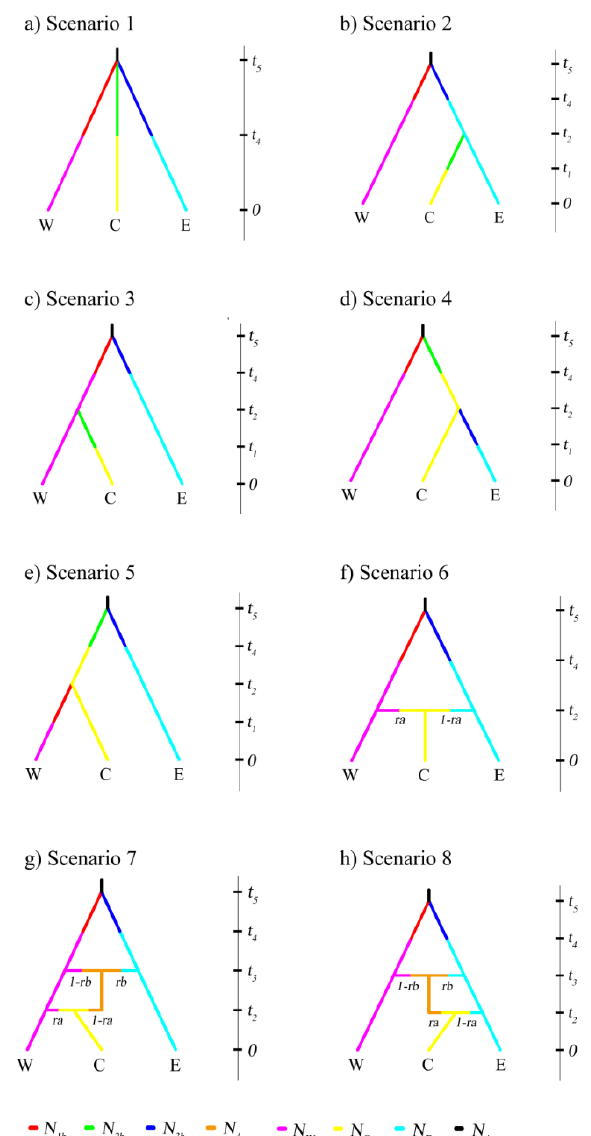
Figure A1. Eight hypothesized evolutionary scenarios for the western, central, and eastern groups of Castanopsis sclerophylla . N A , N W , N C , N E , and N 4 : effective population size of ancestral population (A), the western (W), central (C), and eastern (E) group, and an unsampled population. N 1b , N 2b , and N 3b : size reduction of the western and eastern group. t 1 , t 2 , t 3 , t 4 , and t 5 : times of different evolutionary events. r a , r b : admixture rate at different times. ( a ) The ancestral population splits into three groups, and their effective population sizes increase later; ( b ) The ancestral population splits into the western and eastern groups, then the central group diverges from the eastern group; ( c ) The ancestral population splits into the western and eastern groups, then the central group diverges from the western group; ( d ) The ancestral population splits into the western and central groups, then the eastern group diverges from the central group; ( e ) The ancestral population splits into the central and eastern groups, then the western group diverges from the central group; ( f ) The ancestral population splits into the western and eastern groups, the central group is derived from an admixture event; ( g ) The ancestral population splits into the western and eastern groups, the central group is derived from recurrent admixture with the western group; ( h ) The ancestral population firstly splits into the western and eastern groups, the central group is derived from recurrent admixture with the eastern